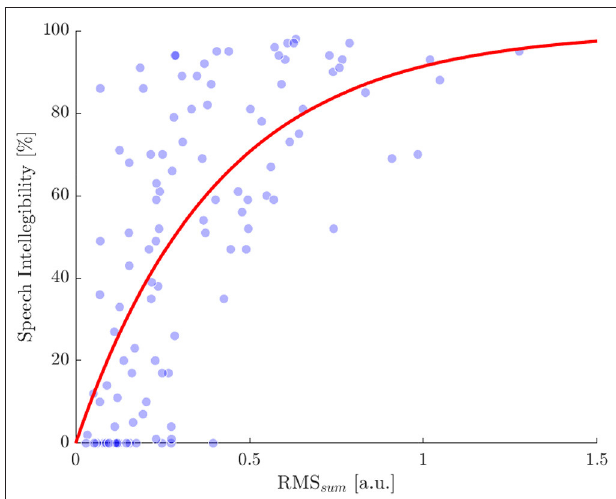
FIGURE 6 | Comparison of speech intelligibility and the RMS sum obtained for each 1 SNR condition and subject. Single values are indicated by blue dots. The red line shows a exponential function fitted to the single values. Root mean square error of the dots compared with the fitted curve is 25% and the RMS sum value related to an intelligibility of 50% is